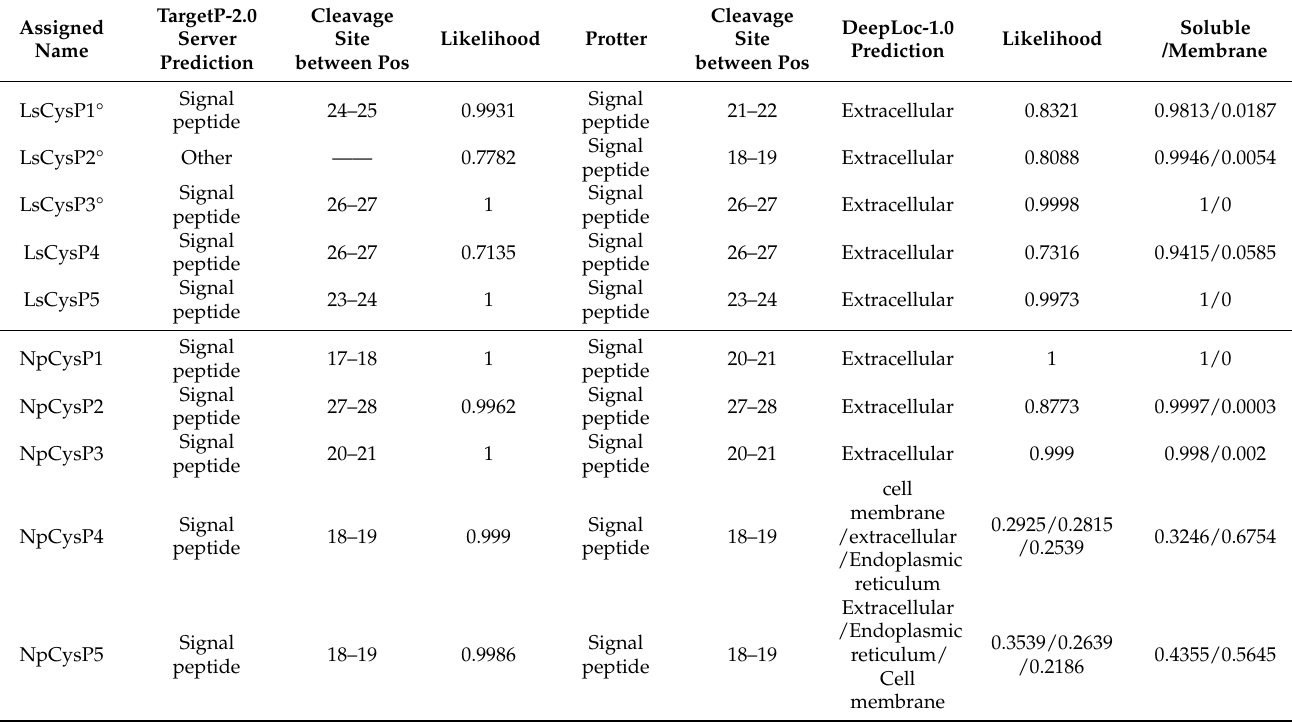
Table 2. Predicted cellular location of L. styraciflua and N. parvum CysRPs.